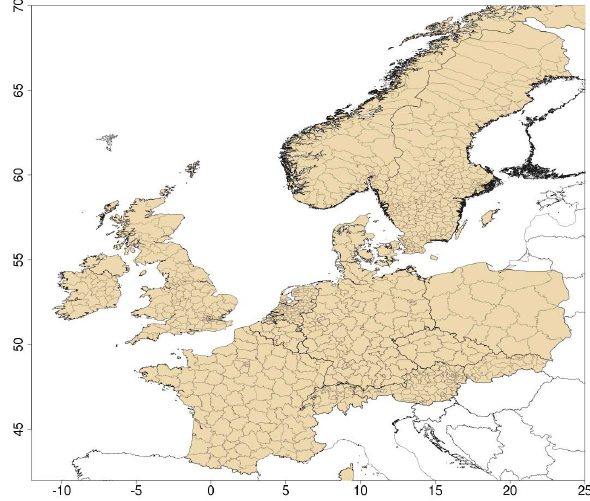
Fig. 1. Analysis domain is formed by 15 European countries. Each countries is further divided in regions known as CRESTA (www. cresta.org) defined with respect to the distribution of population and buildings. CRESTAs generally correspond to 2 digit postal